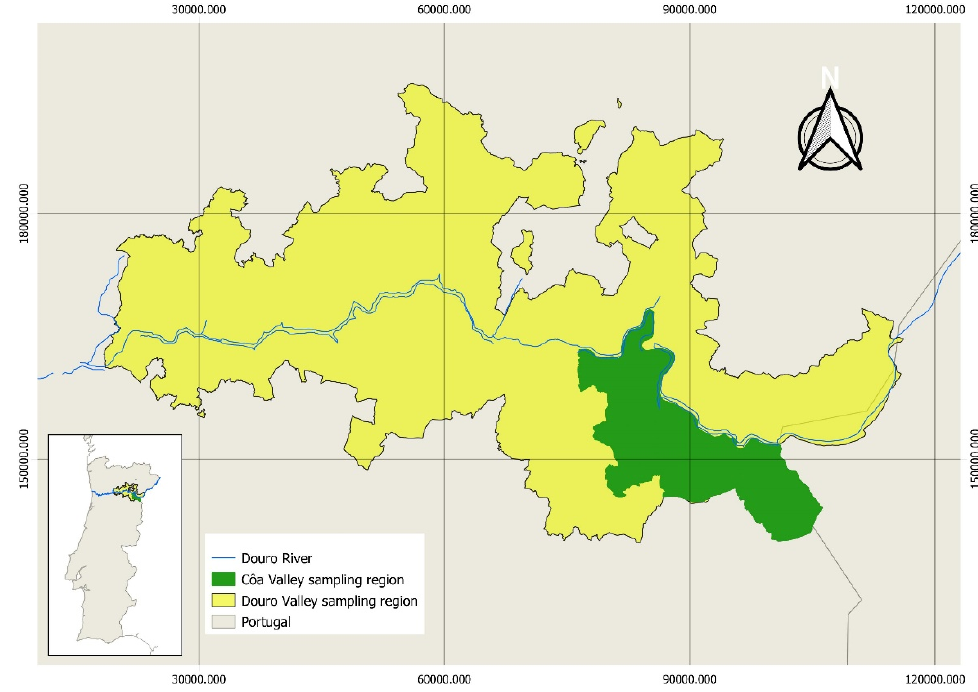
Figure 1. Côa Valley and Douro Valley sampling regions. Map projected in ETRS89/PT-TM06. Figure 1. C ô a Valley and Douro Valley sampling regions. Map projected in ETRS89/PT-TM06. 2.2. Quality Physicochemical Parameters, Oxidative Stability, Total Phenols Content,